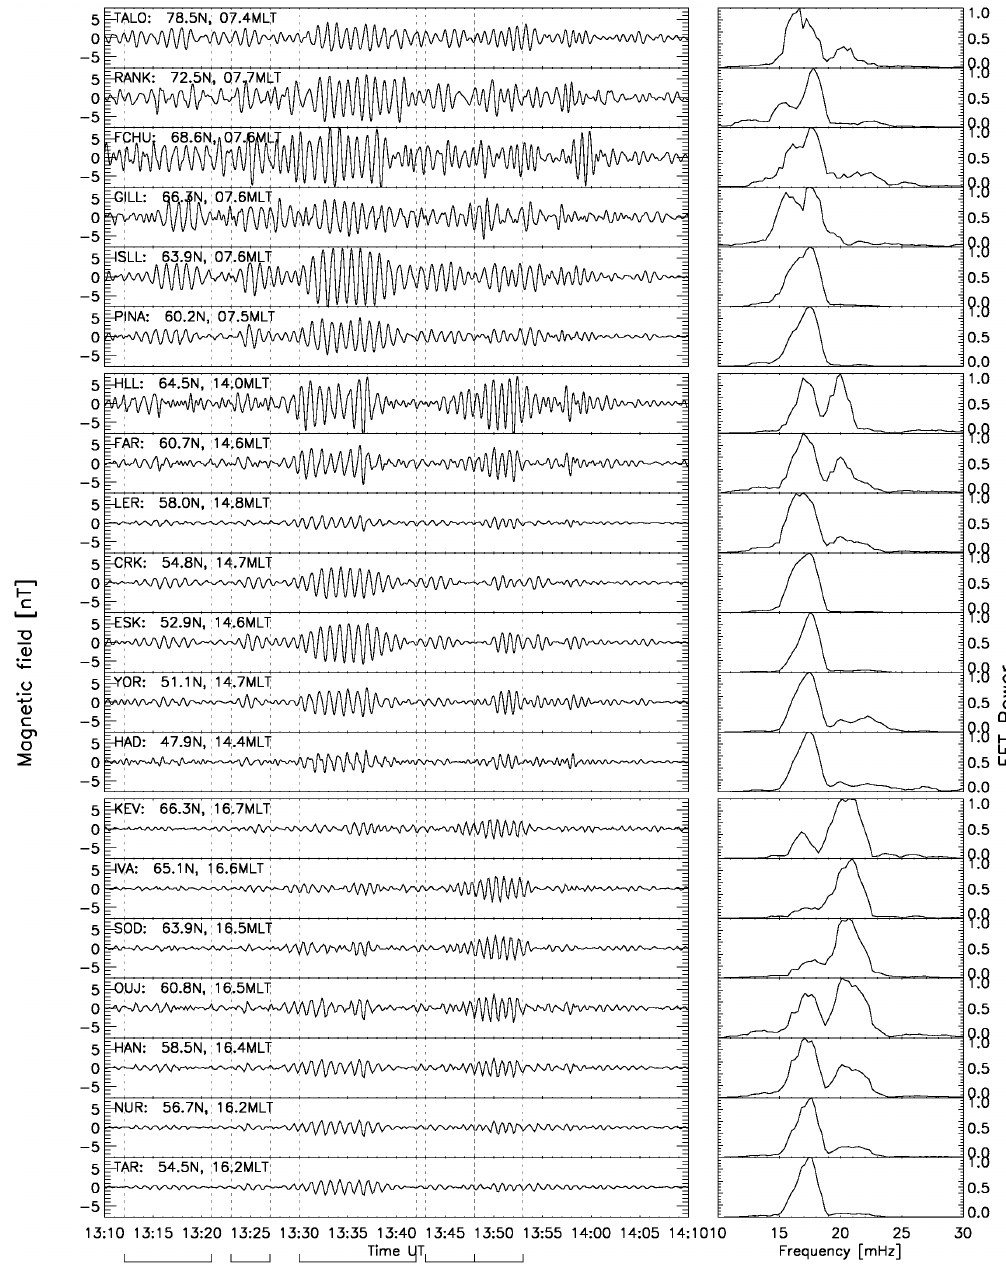
Fig. 1. Bandpass filtered (20 to 80s) ground based magnetometer data from three latitudinal profiles using CARISMA, SAMNET and IMAGE stations on the left. Five pulsation events are marked by vertical dashed lines. The panels on the right show the normalized smoothed Fourier